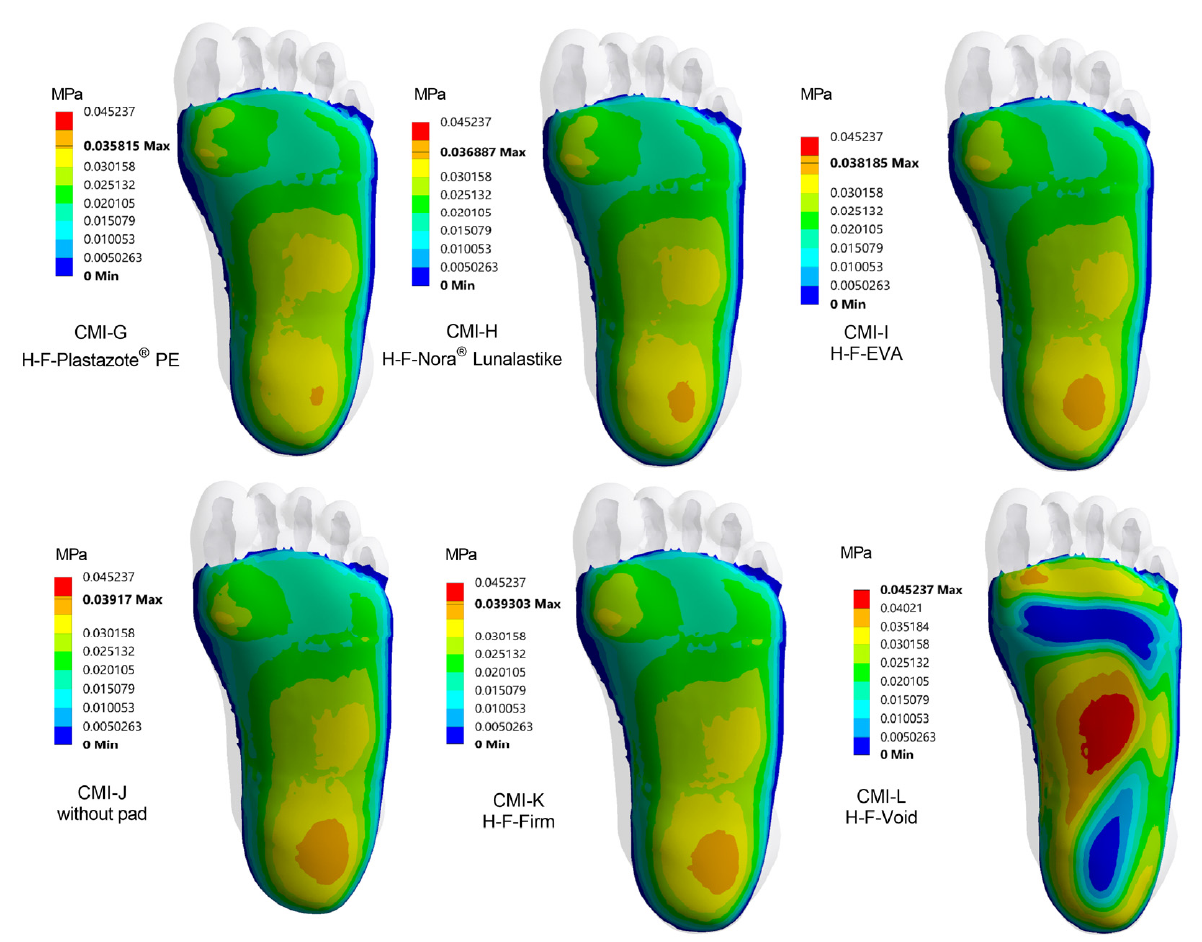
Figure 5. The plantar pressure obtained from FEA models using the heel–forefoot pad fabricated from soft to hard material properties (CMI-G to CMI-K), without heel–forefoot pad (CMI-J), and with a void (CMI-L).